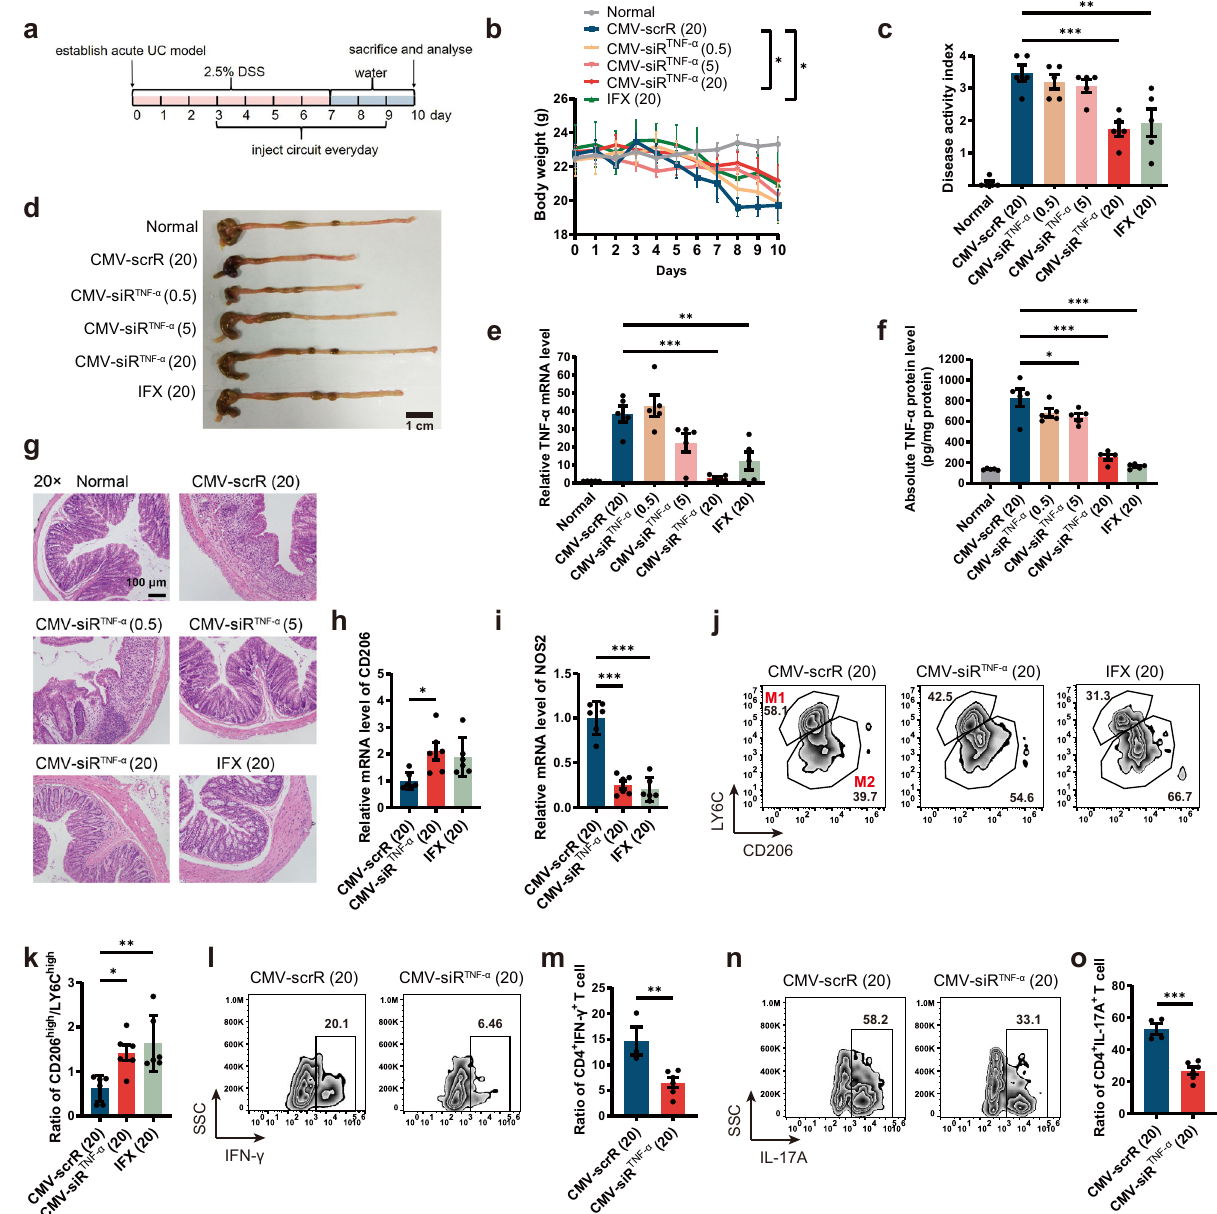
Fig.5|IntravenousinjectionoftheCMV-siR TNF- α circuitprotectsmicefromDSS- induced acute UC. a Flow chart of the experimental design. b Body weight curves ( n =5ineachgroup). c DigitalAccelerationIndex(DAI)scores( n =5ineachgroup). d Representativemacroscopicfeaturesofcolons.Scalebar:1cm. e QuantitativeRT- PCR analysis of the relative expression levels of TNF- α mRNA in the colon ( n =5 in each group). f Determination of the absolute expression levels of TNF- α protein in thecolonbyELISA( n =5ineachgroup). g RepresentativeimagesofH&Estainingof colon sections. Scale bar: 100 μ m. Each experiment was repeated independently threetimes,andrepresentativeresultsareshown. h , i QuantitativeRT-PCRanalysis of the relative expression levels of CD206 and NOS2 mRNA in the colon ( n =6